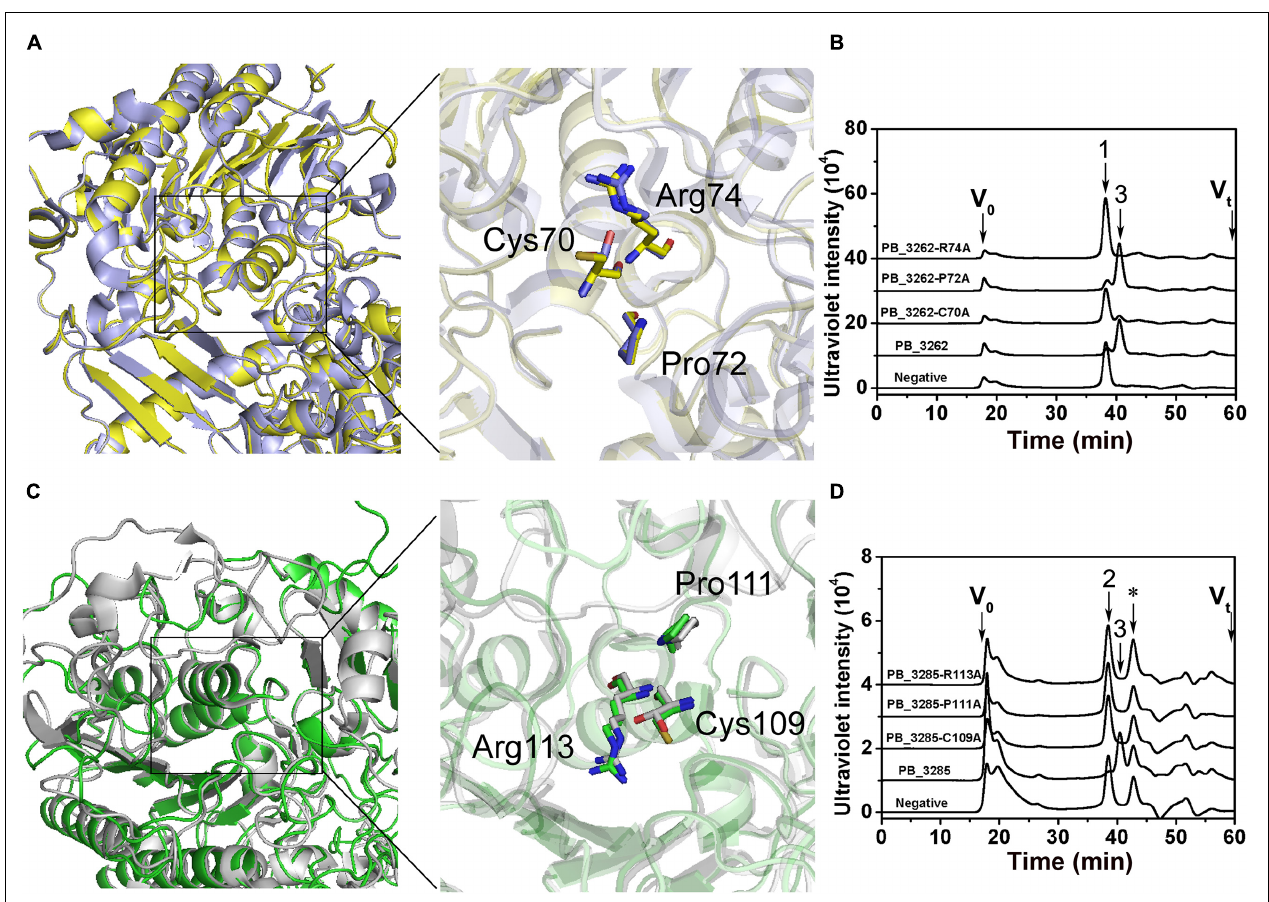
FIGURE 8 | Tertiary structure modeling, structural alignment and site direct mutants of PB_3262 and PB_3285. Structural superposition of PB_3262 ( yellow ) to endoVB4SF ( cyans ) and PB_3285 ( green ) to GalN6S ( gray ). The homology modeling of PB_3262 (A) and PB_3285 (C) was predicted using SWISS-MODEL software online, and the conserved residues in active sites are shown with sticks structure. The conserved residues of PB_3262 (B) and PB_3285 (D) were individually replaced with Ala by site-directed mutagenesis. The activities of the mutants against (cid:49) A (B) and (cid:49) C (D) were estimated by gel filtration HPLC on a Superdex Peptide column at 232 nm. V 0 , void volume; V t , total volume. The elution positions of unsaturated CS disaccharides are indicated as follows: 1, (cid:49) A; 2, (cid:49) C; and 3, (cid:49) O. ∗ , salt from reaction